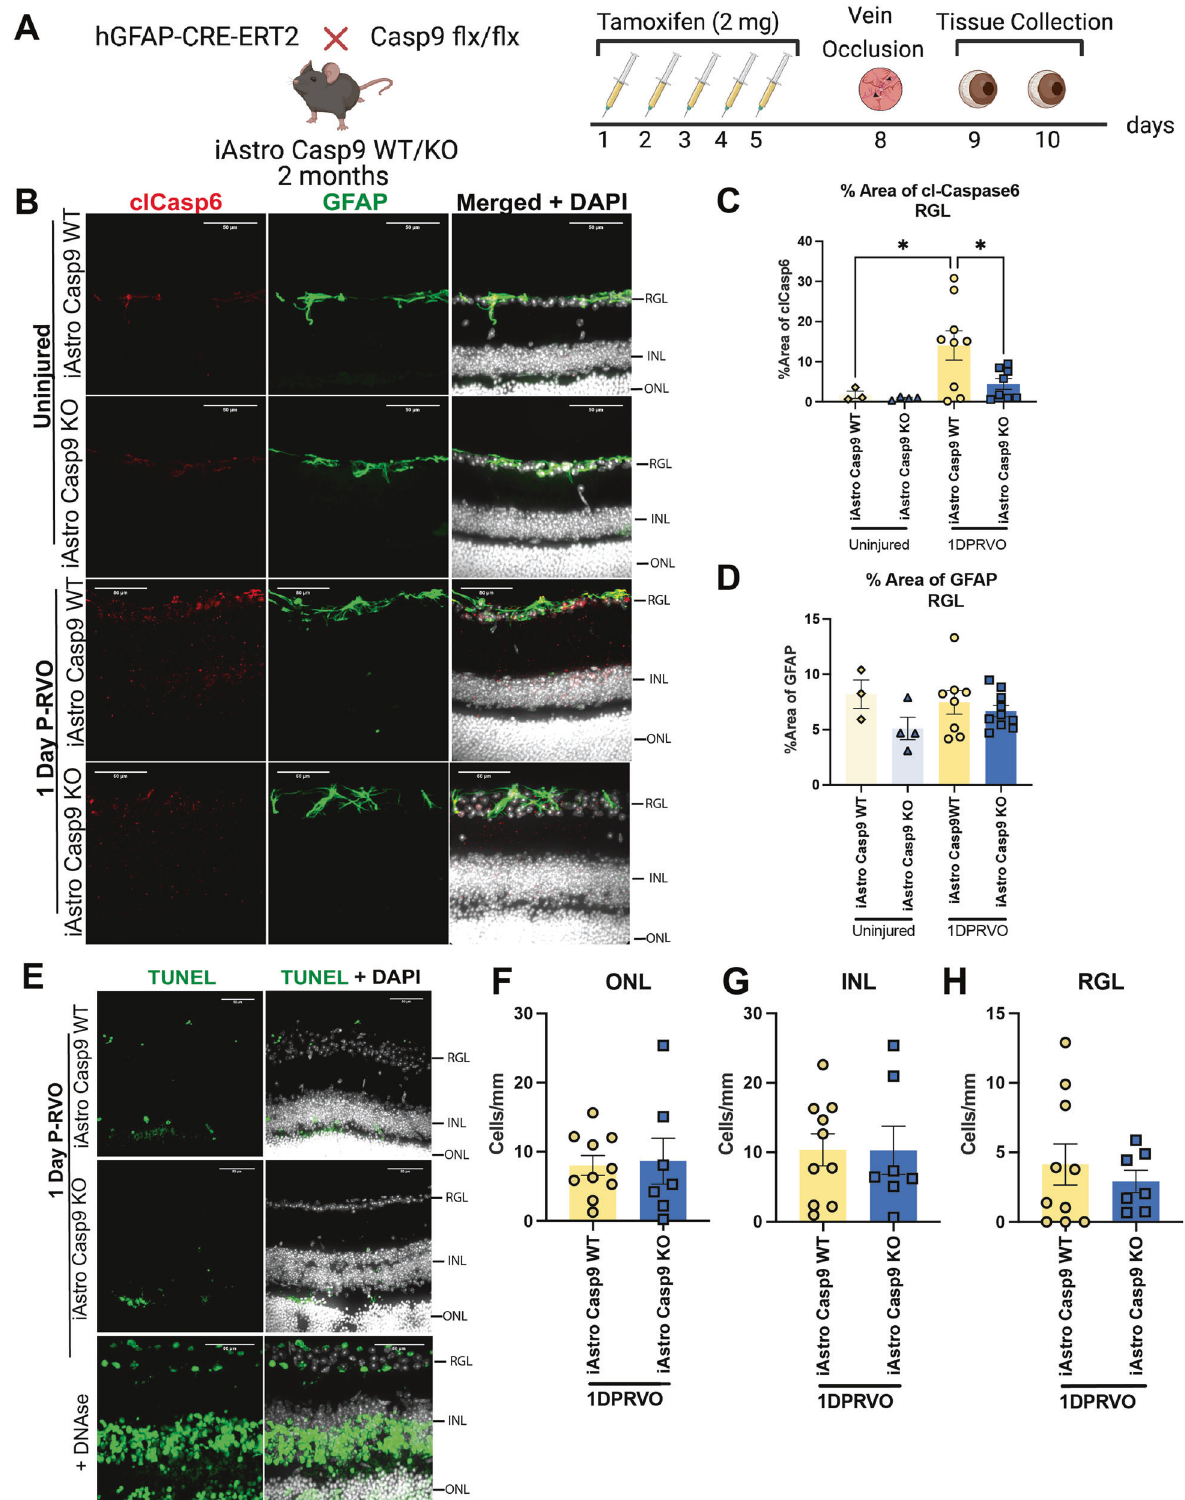
Fig. 6 Astro Casp9 is upstream of astroglial cl-caspase-6. A Experimental schematic. Two-month-old iAstro Casp9 WT/KO mice were treated with tamoxifen for fi ve consecutive days. After two days, animals were subjected to RVO, and eyes were collected one day P-RVO. Created with Biorender.com. B Retinal cross-sections from uninjured and one day P-RVO iAstro Casp9 WT and KO mice were stained with cl-caspase-6 (red), GFAP (green), and DAPI (white). C Percent area of cl-caspase-6 in RGL. Scale bar 50 µm. D Percent area of GFAP in RGL and NFL. E Retinal cross- sections from uninjured and one day P-RVO iAstro Casp9 WT and KO mice were stained with TUNEL (green) and DAPI (white). Number of cells that are TUNEL positive for F ONL, G INL, and H RGL. Error bars mean ± SEM, One-way ANOVA, Fisher ’ s LSD test. * P ≤ 0.05 and ** P ≤ 0.01. Retinal ganglion layer (RGL), inner nuclear layer (INL), and outer nuclear layer (ONL). Scale bar = 50 µm.